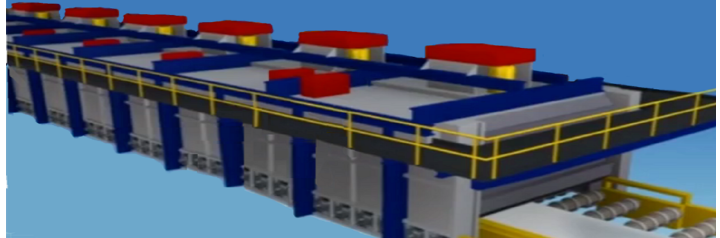
Figure 2. The independent equipment for the research of aluminium alloy quenching process 3D